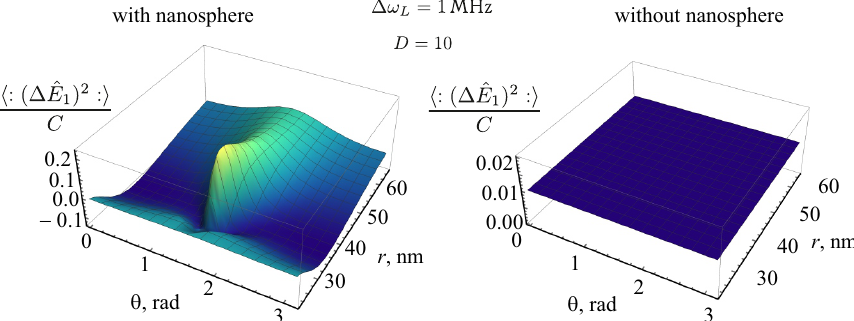
Figure 15. Dependences of quantity (cid:104) : ( ∆ ˆ E 1 ) 2 : (cid:105) normalized to C on the position of a QE at D = 10 in the presence of a nanosphere ( left ) and in its absence ( right